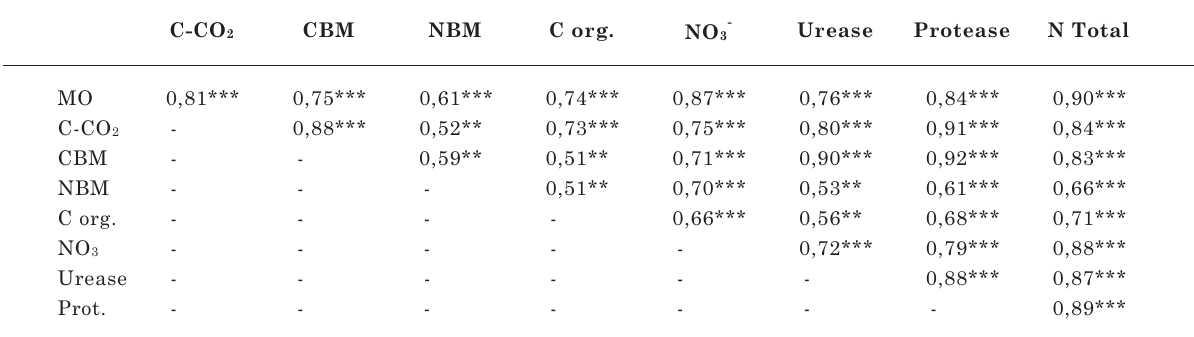
Quadro 3. Correlação entre as variáveis estudadas dos solos pastejados pelos